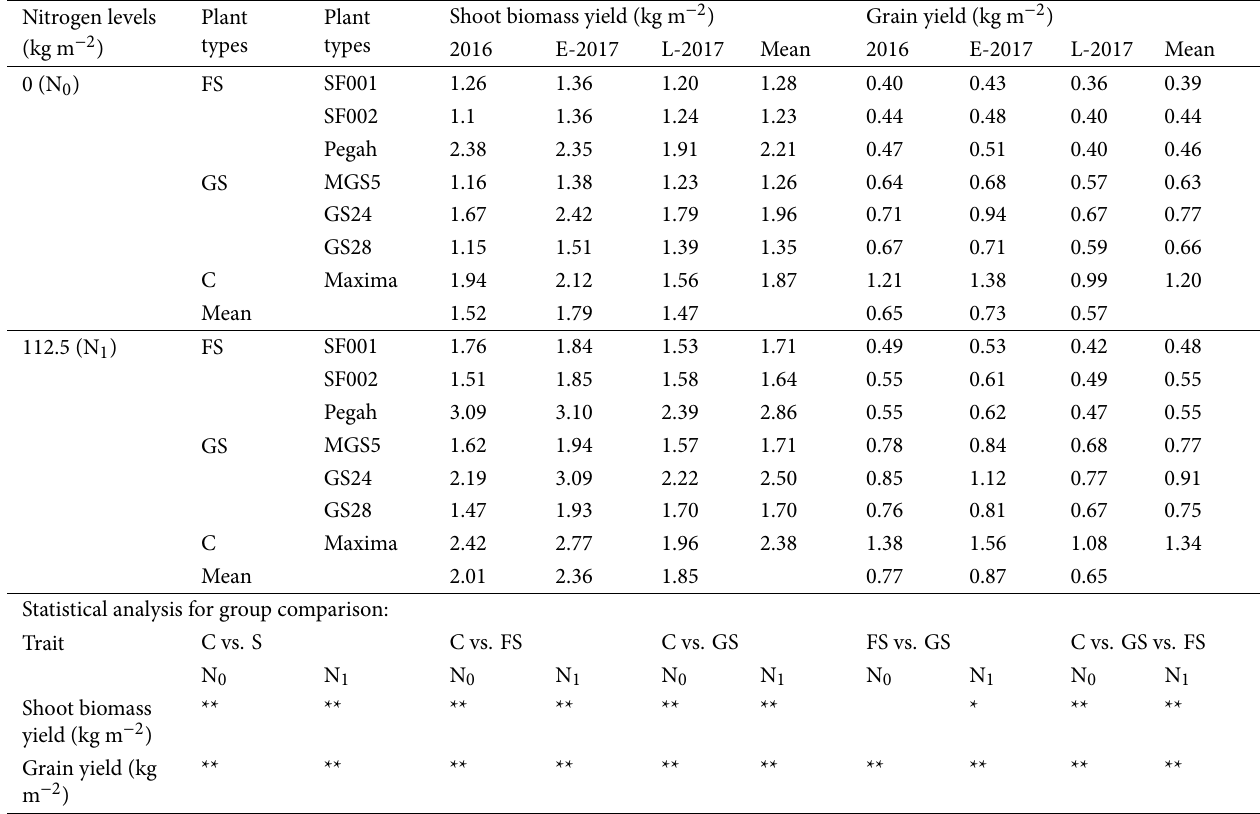
Table 4 Statistical analysis for group comparisons (among the corn, grain sorghum, and forage sorghum genotypes studied) as well as comparisons of means for shoot biomass and grain yields (kg m